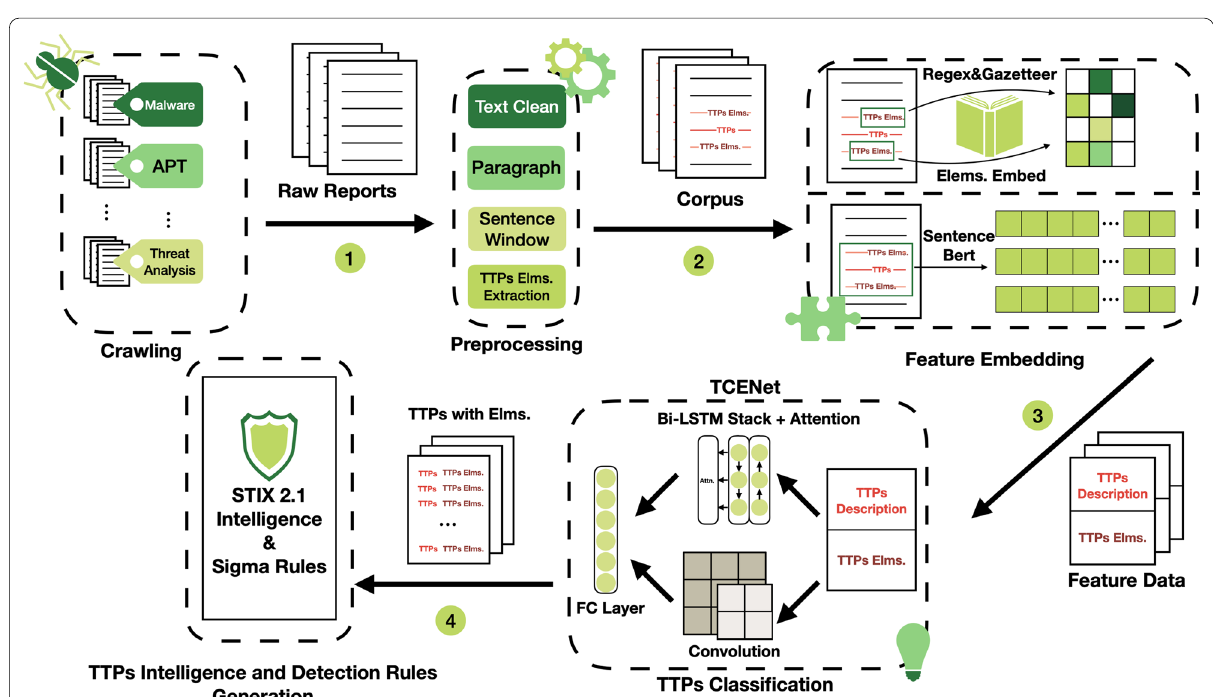
Fig. 3 Threat Context Enhanced TTPs Intelligence Mining Framework (TIM). The whole workflow starts with the crawling module. Via preprocessing, feature embedding, TTP classification (TCENet), and intelligence&detection rule generation modules, we finally obtain TTP intelligence in STIX 2.1 format and Sigma detection rules. We use these TTP intelligence and detection rule for intelligence sharing and